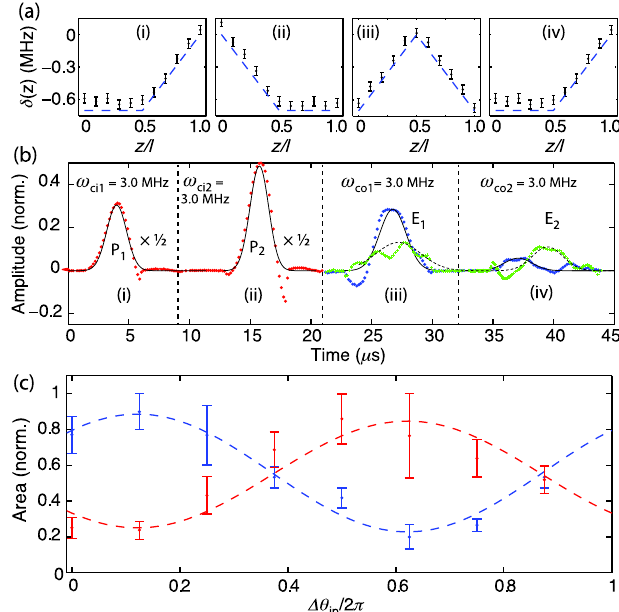
(a) Two-photon detuning (cid:5) as a function of position z along the memory (normalized to length l ) due to (i)–(ii) input gra- dients and (iii)–(iv) output gradients corresponding to times (i)–(iv) in (b). Blue (dashed) lines correspond to the desired field, and points correspond to the measured magnetic field. (Error bars are due to the sensitivity of the Gauss meter.) (b) Interference of two pulses, initially time separated, (i) P 1 and (ii) P 2 (red dashed lines), which have the same center frequency. (iii) Initial E 1 , and (iv) secondary E 2 superpositions of the two pulses. Blue points and solid line correspond to maximum constructive interference for E 1 , while green crosses and dashed line correspond to maximum constructive interfer- ence for E 2 . Points correspond to demodulated data averaged over 100 traces, lines correspond to the Gaussian fit to the data, and ! c values correspond to center frequencies of pulses. (c) The change in area (normalized to the maximum intensity of the individual echoes) as a function of the relative phase of the input pulses (cid:2) (cid:7) ip for (i) E 1 , and (ii) E 2 . Points represent data extracted from the fit (error bars are from standard deviation of 100 fits), and the dashed line corresponds to a fit to the